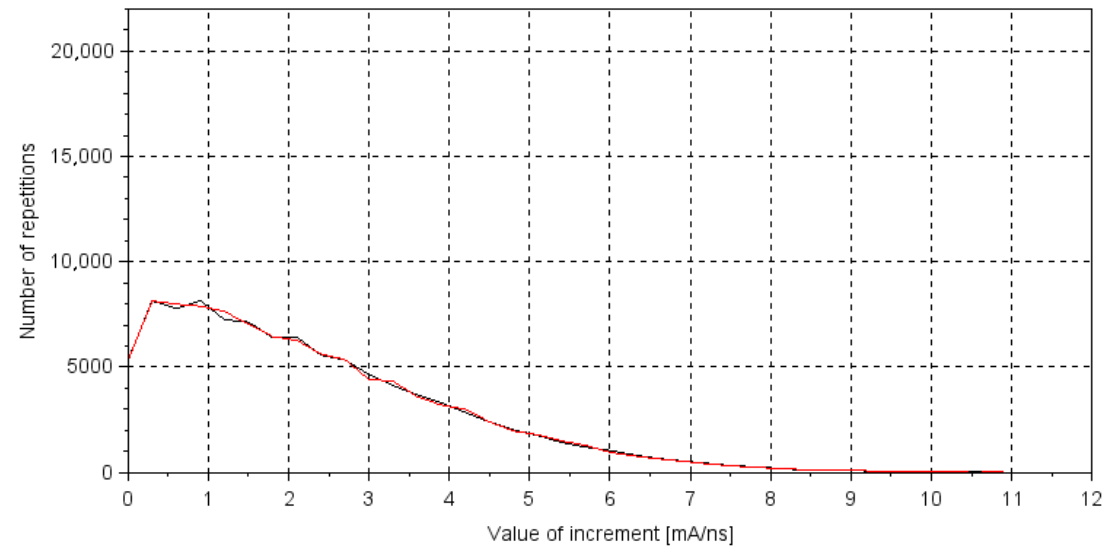
Figure 7. Figure showing 100 kpts decompositions of signals with no arc (conditions: shorted spark gap and current of 500 mA DC at each measurement).